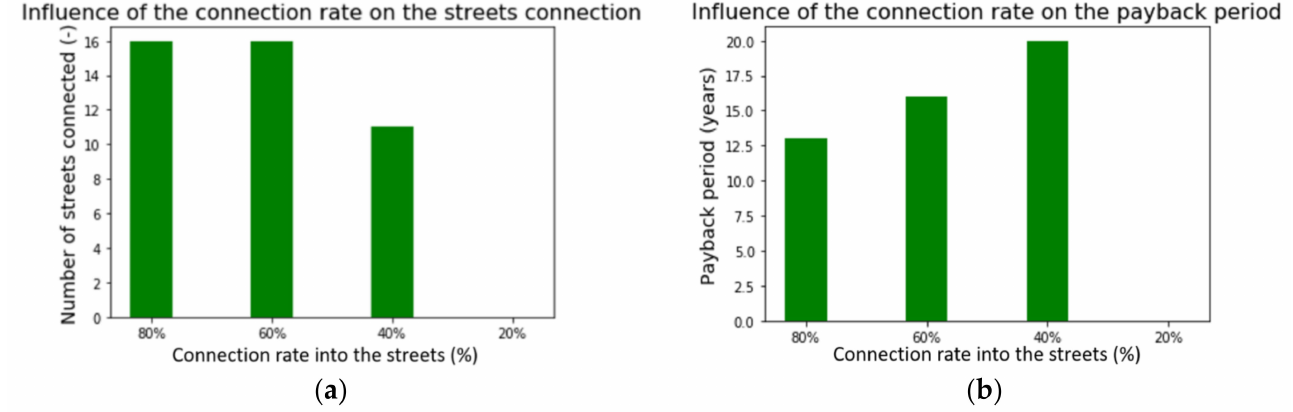
Figure 14. ( a ) Number of streets connected; ( b ) payback period.